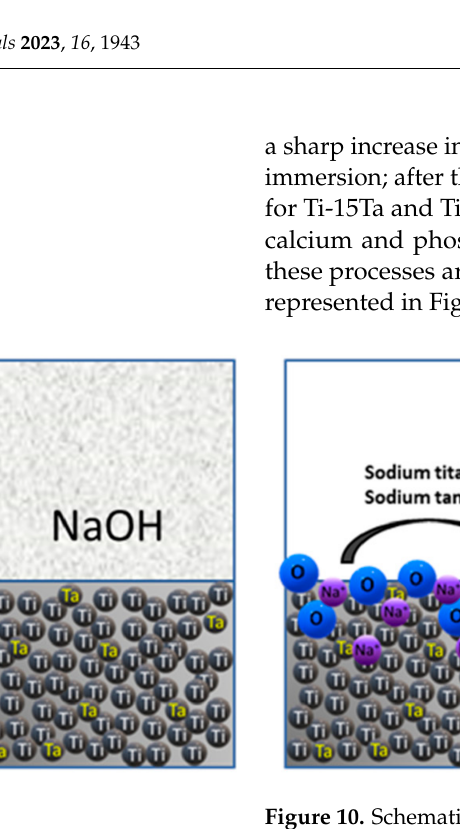
Figure 10. Schematics of apatite formation on